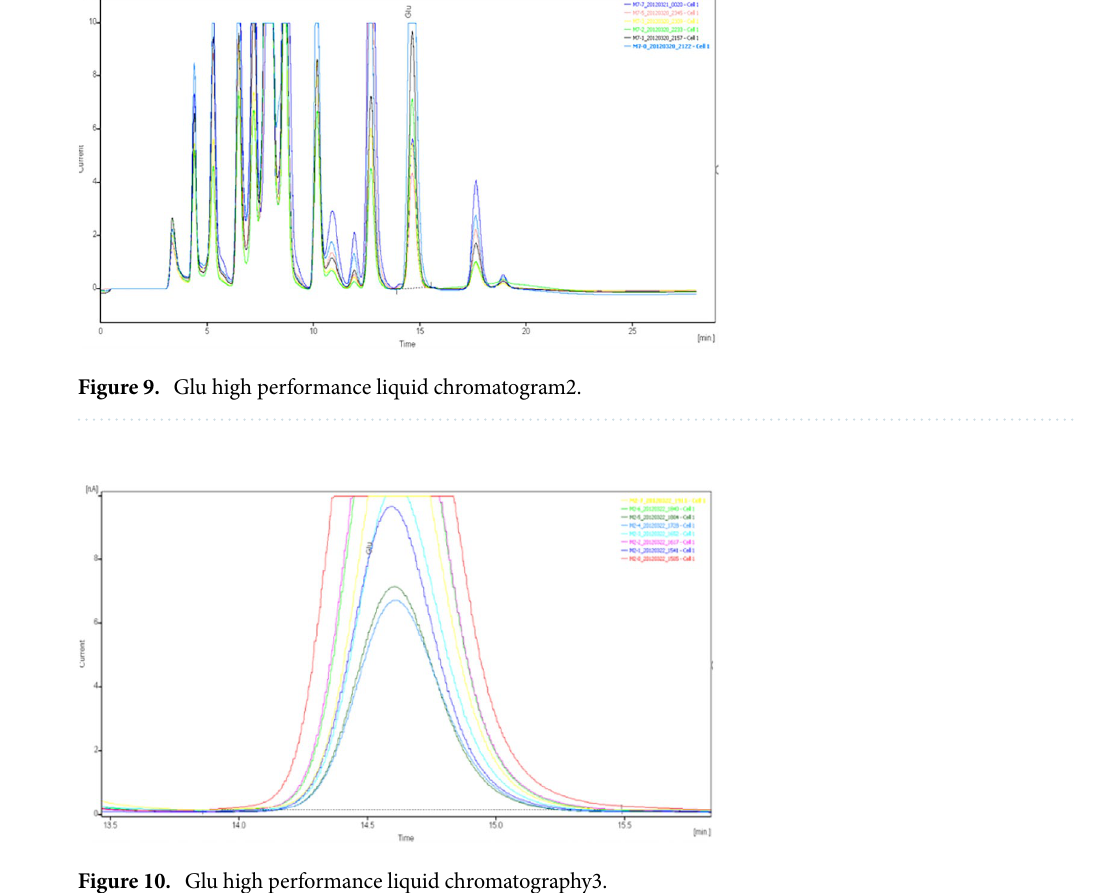
Figure 10. Glu high performance liquid